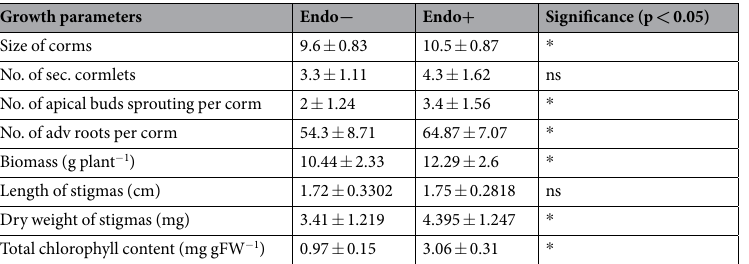
Table 1. Effect of endophyte (CS10E4) on physiological and growth parameters of Crocus sativus plants. (Endo − ) are endophyte-free control and (Endo + ) are the endophyte treated Crocus plants. Values are the means of 35 biological replicates ± S.D. Comparisons among means were carried out using Student T test at a significance level of p ≤ 0.05 using GraphPad InStat tm software (V2.05). Further, * indicates significance at p ≤ 0.05 and ns stands for